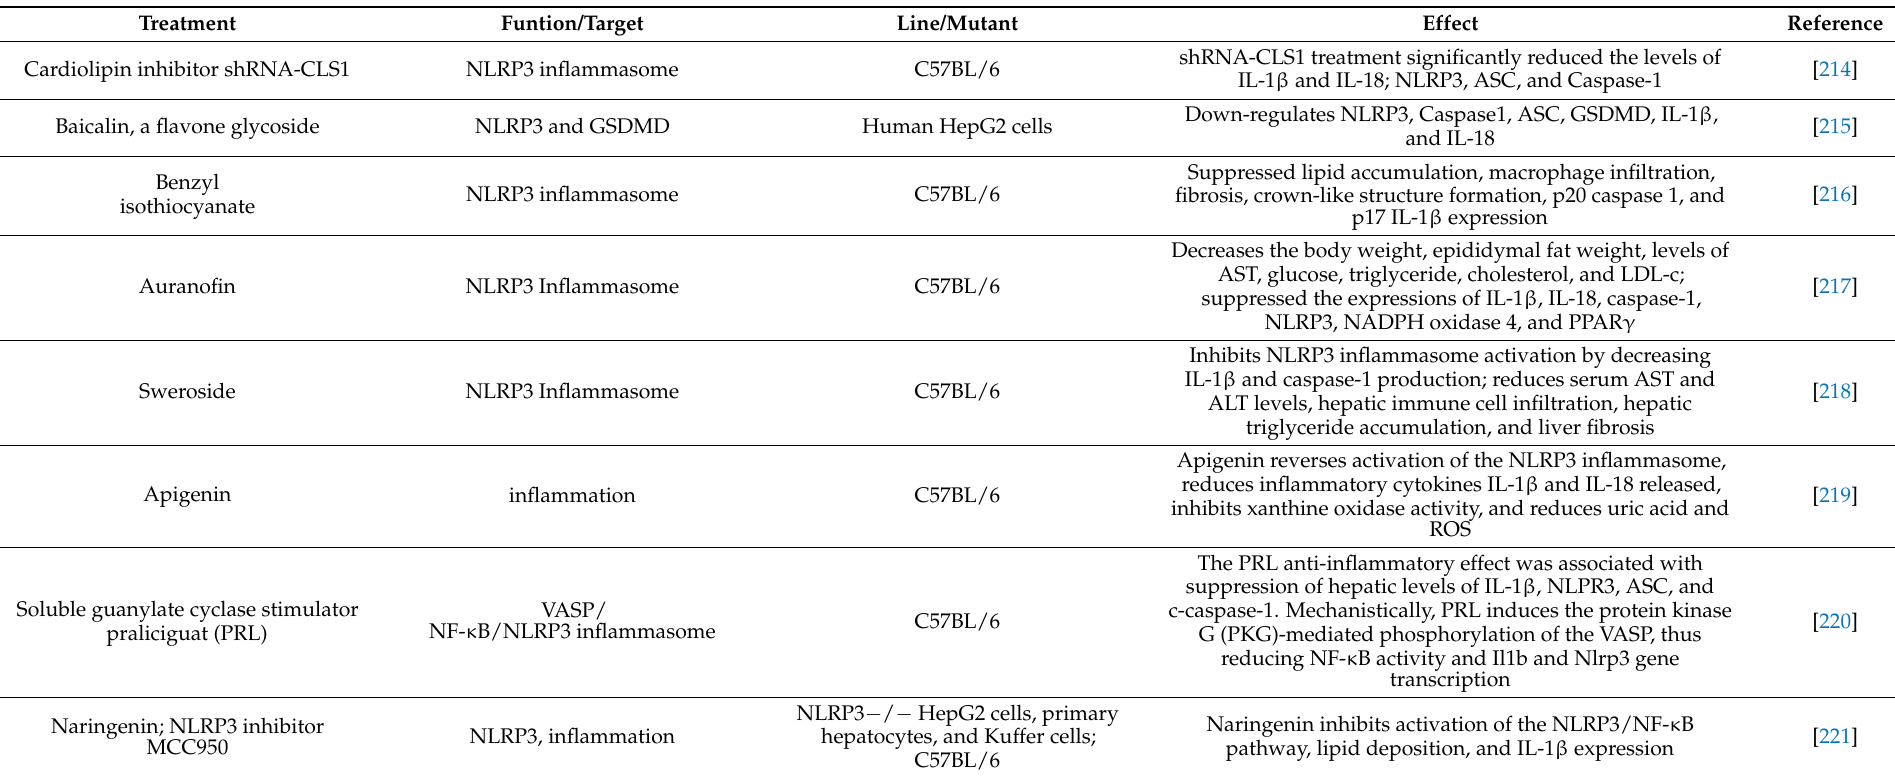
Table 2. NLRP3 inflammasome-targeting NAFLD